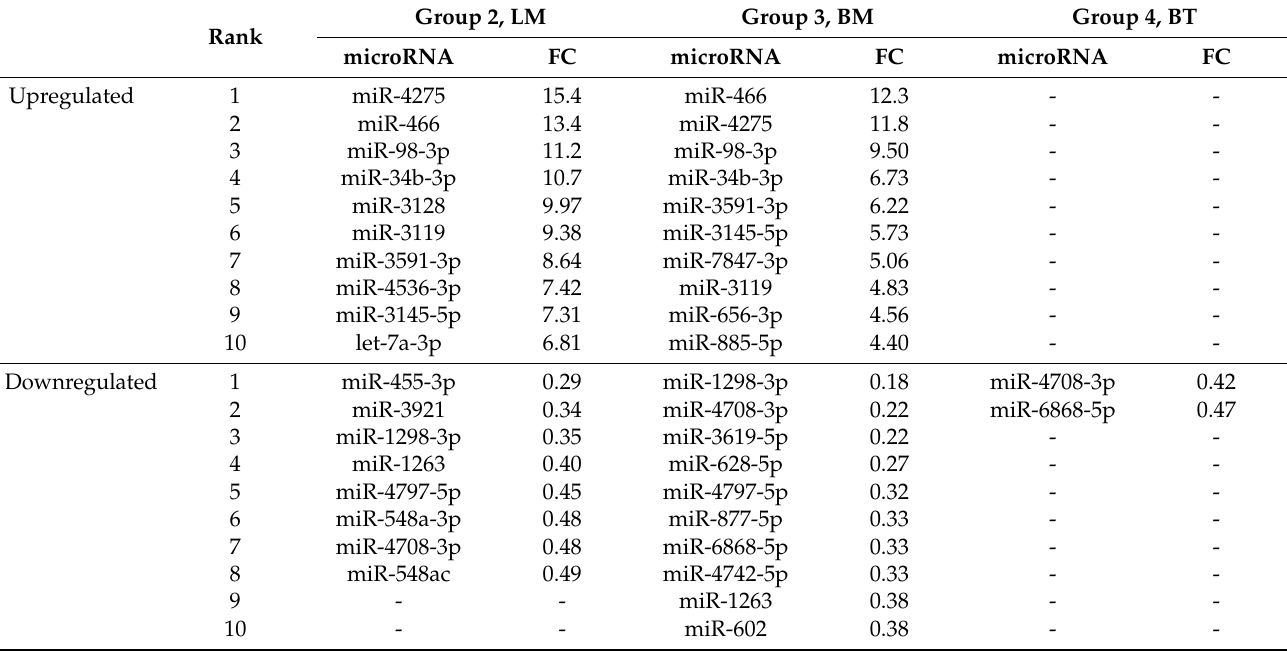
Table 2. Top 10 significantly upregulated and downregulated extracellular microRNA in CSF from patients with CNS tumors compared to